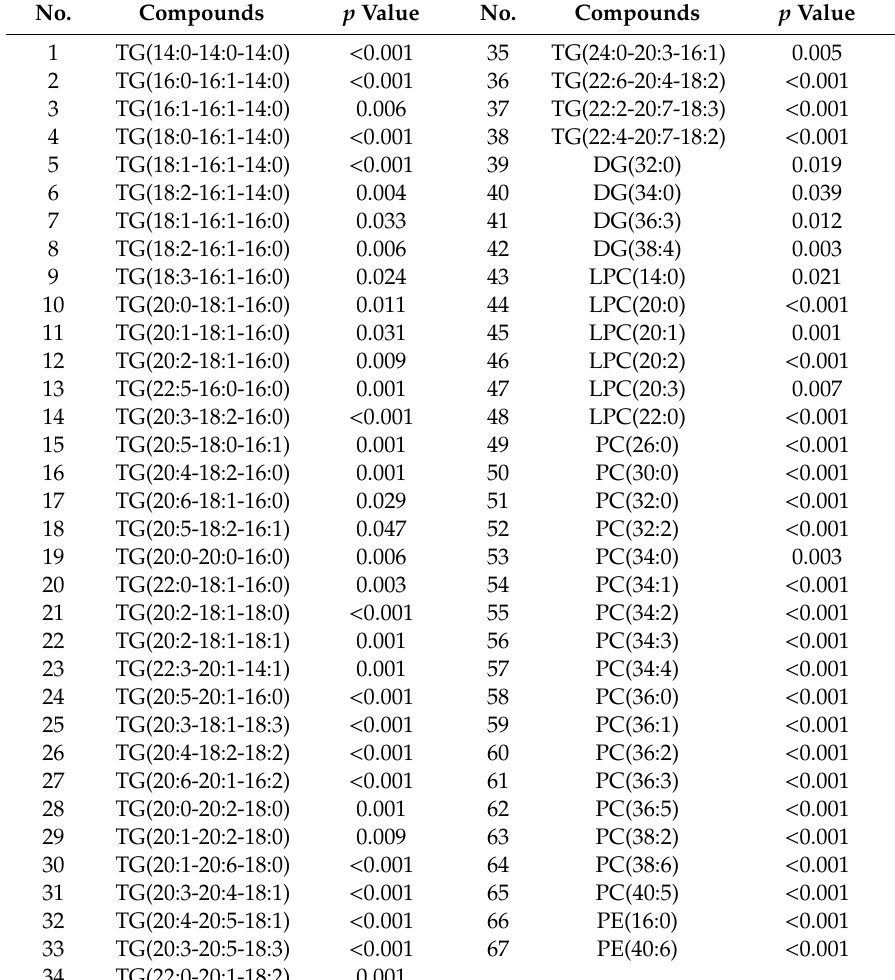
Table 1. The list of validated di ff erentially regulated lipids (vDRLs) of the six groups (normal control, SHR, SHR + 100 mg / kg of Drug, SHR + ASF 200, 400, 600 mg / kg) selected by the ANOVA test ( p value <